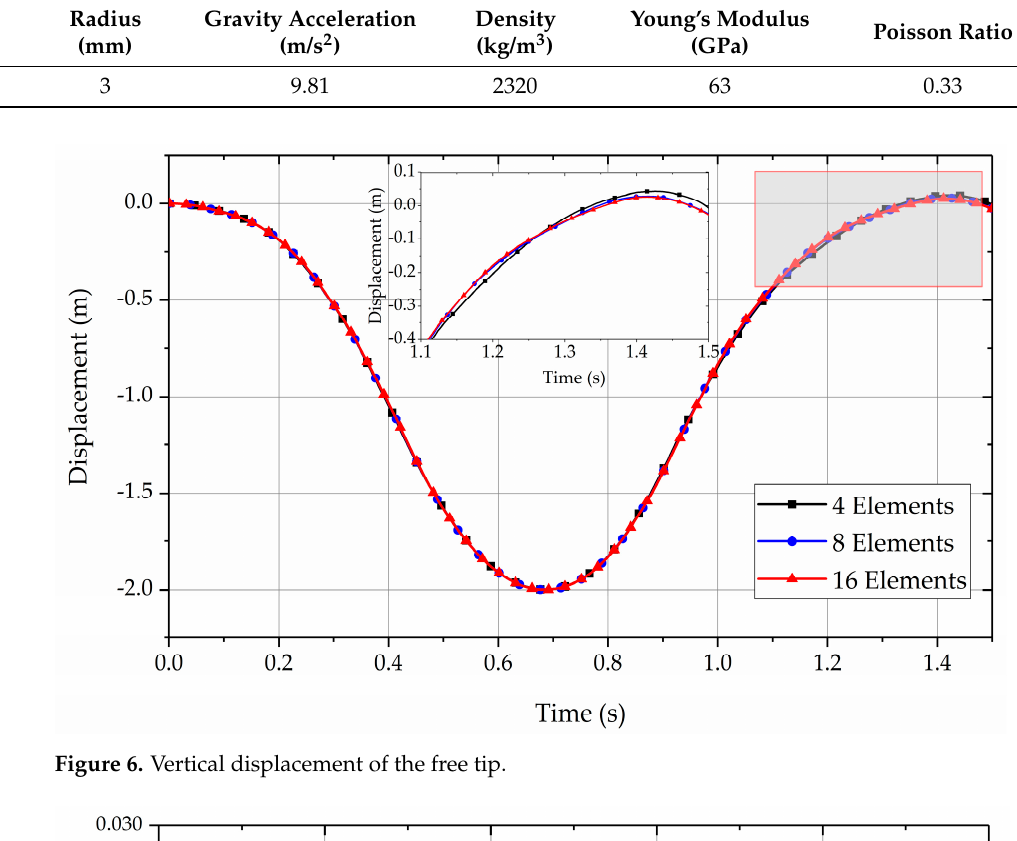
Table 1. Parameters of the flexible pendulum.